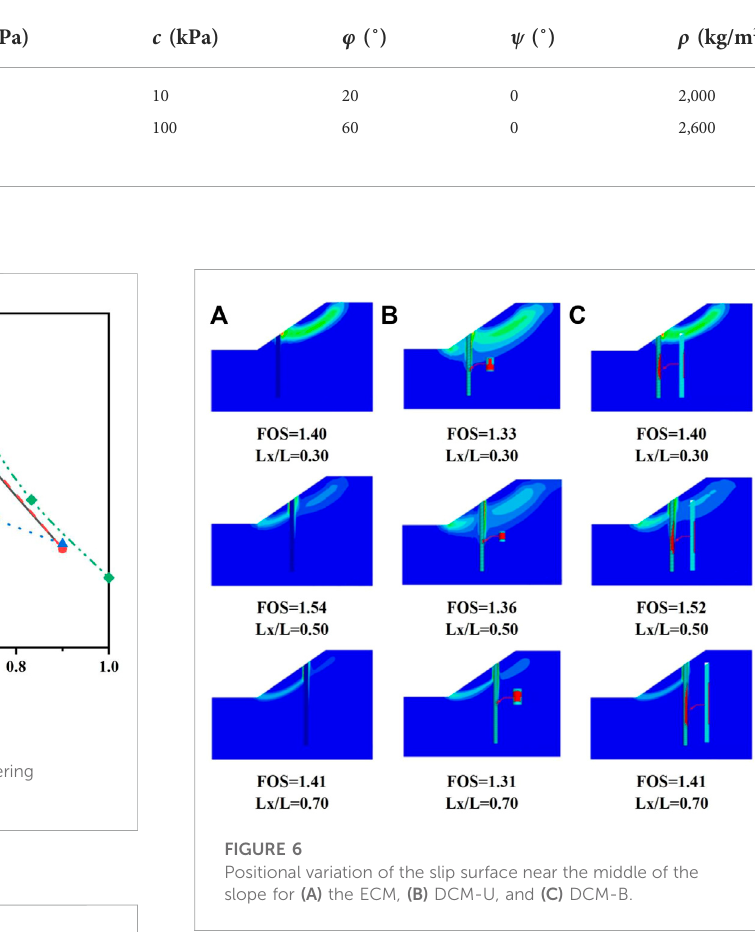
TABLE 1 Mechanical parameters of soil and pile.